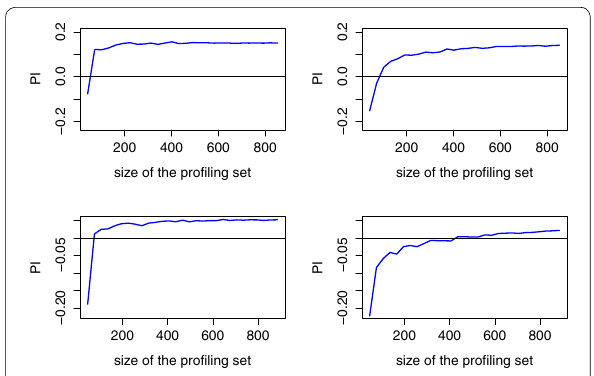
Fig. 7 Evolution of the PI in function of the size of the profiling set for Users 3 (top) and 6 (bottom), using average PCA (left) and raw PCA (right)